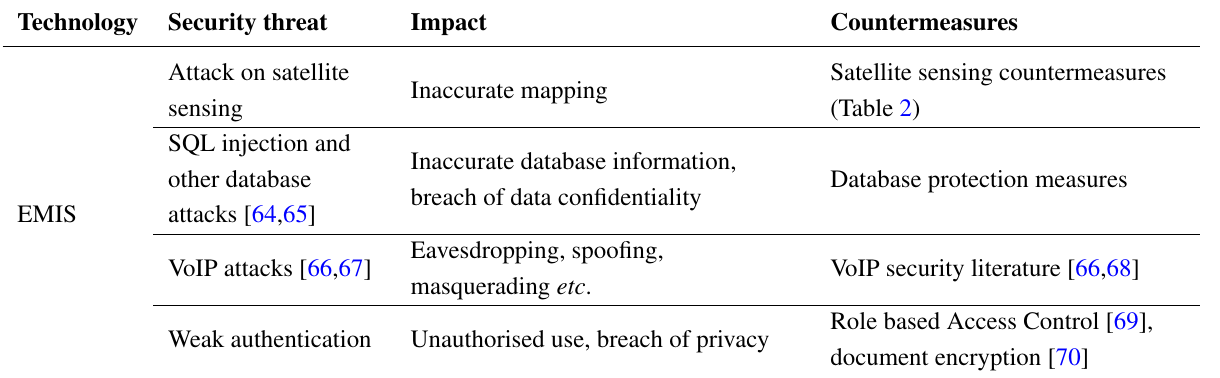
Table 3. EMIS security threats and proposed